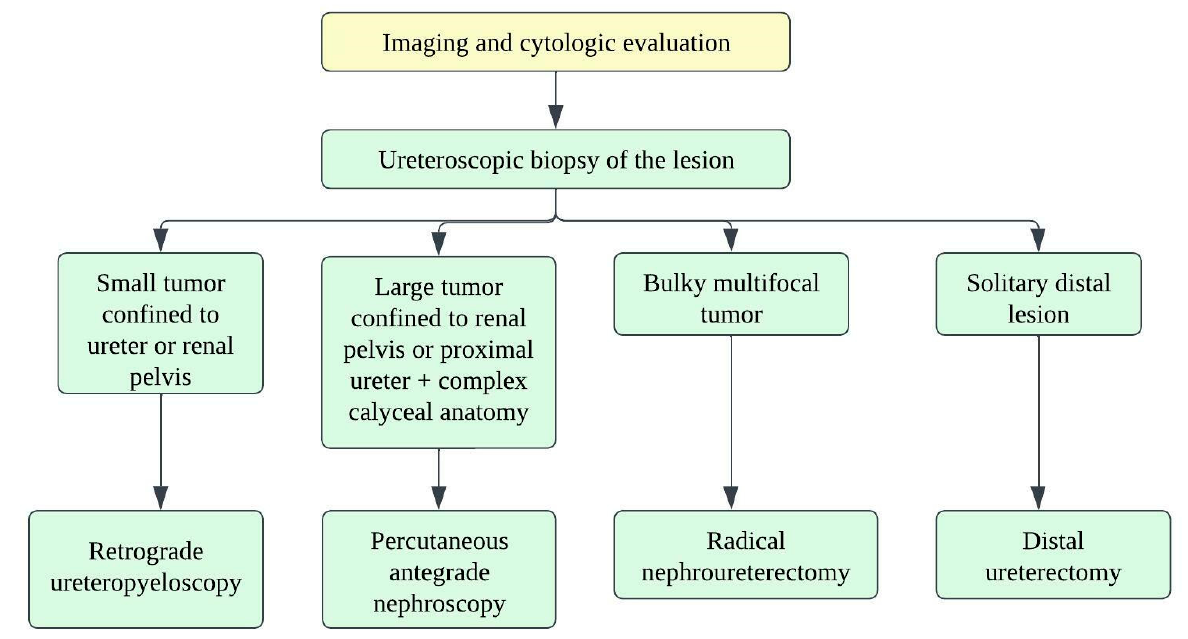
Figure 14. Treatment algorithm for upper urinary tract carcinoma. Table 9. TNM staging of ureteral malignancies [123].